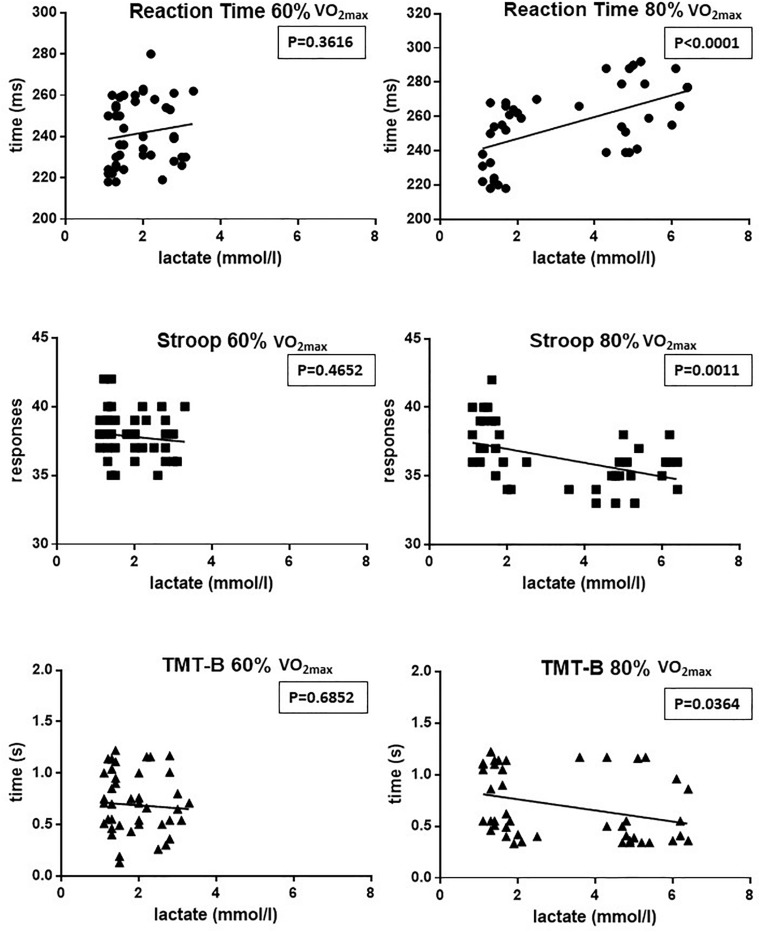
Correlations between blood lactate levels and performance measured for RT, SCWT, and TMT-B in the two different exercise intensities (60% of VO2max on the left and 80% of VO2max on the right). As can be seen, while at 60% of VO2max none of the correlations reaches statistical significance, at 80% of VO2max the 3 correlations are statistically significant (P > 0.05).